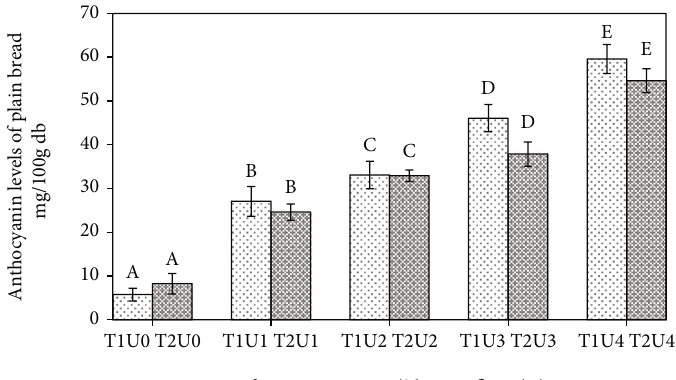
Figure 1: Anthocyanin levels of plain bread with di ff erent baking temperature and yam fl our addition. Note: T1: baking temperature 170 ° C; T2: baking temperature 180 ° C; U0: yam fl our 0%; U1: yam fl our 10%; U2: yam fl our 15%; U3: yam fl our 20%; U4: yam fl our 30%. The letter above the bar graph beside the same number shows that it is not di ff erent based on the DNMRT statistical test at the level of con fi dence 5%.